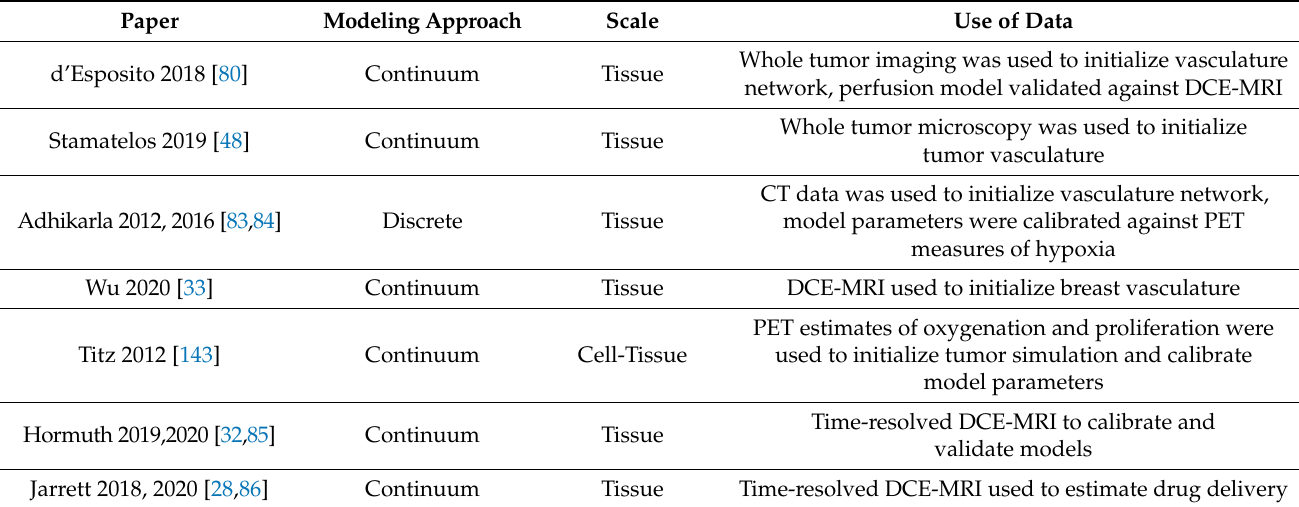
Table 3. Examples of studies integrating imaging data with mathematical modeling at the tissue scale. Paper Modeling Approach Scale Use of Data Whole tumor imaging was used to initialize vasculature Continuum Tissue network, perfusion model validated against DCE-MRI Whole tumor microscopy was used to initialize Tissue tumor vasculature CT data was used to initialize vasculature network, Discrete Tissue model parameters were calibrated against PET measures of hypoxia Tissue DCE-MRI used to initialize breast vasculature PET estimates of oxygenation and proliferation were used to initialize tumor simulation and calibrate model